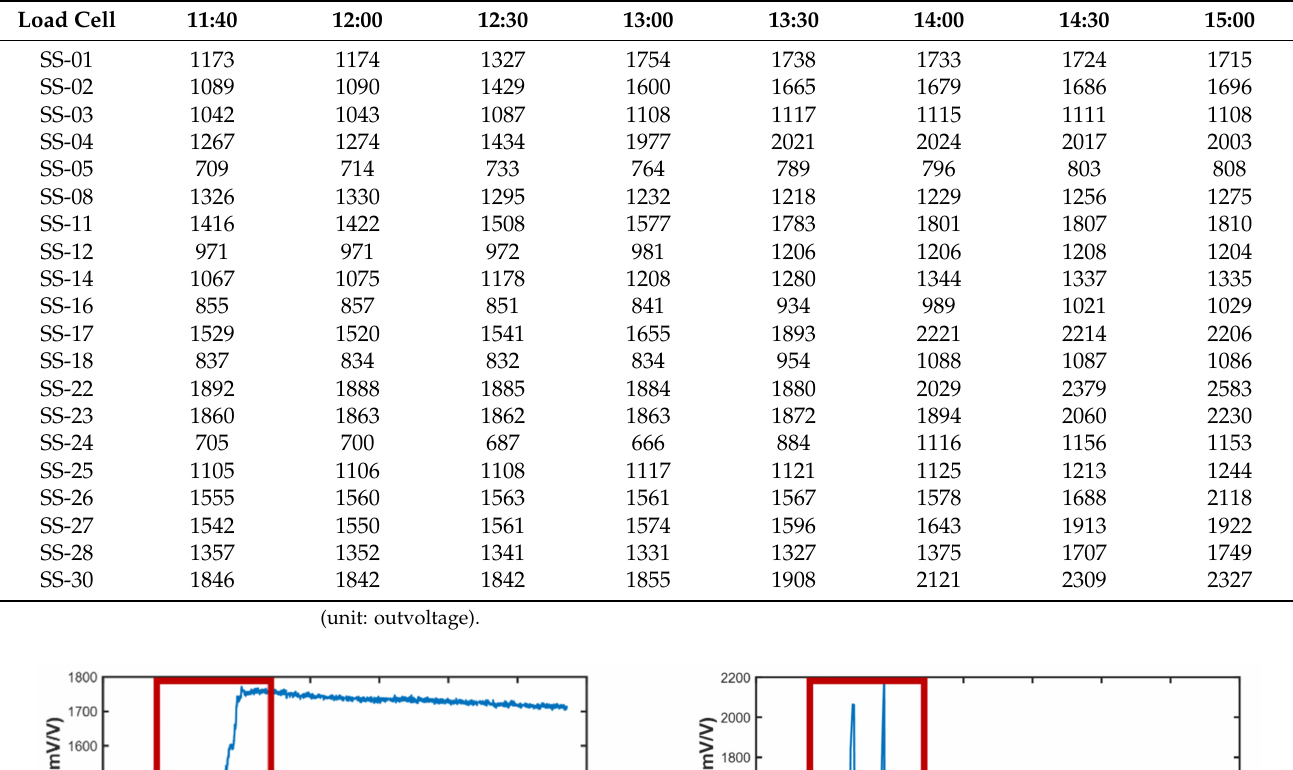
Table 4. Data on remote load-monitoring measurements.